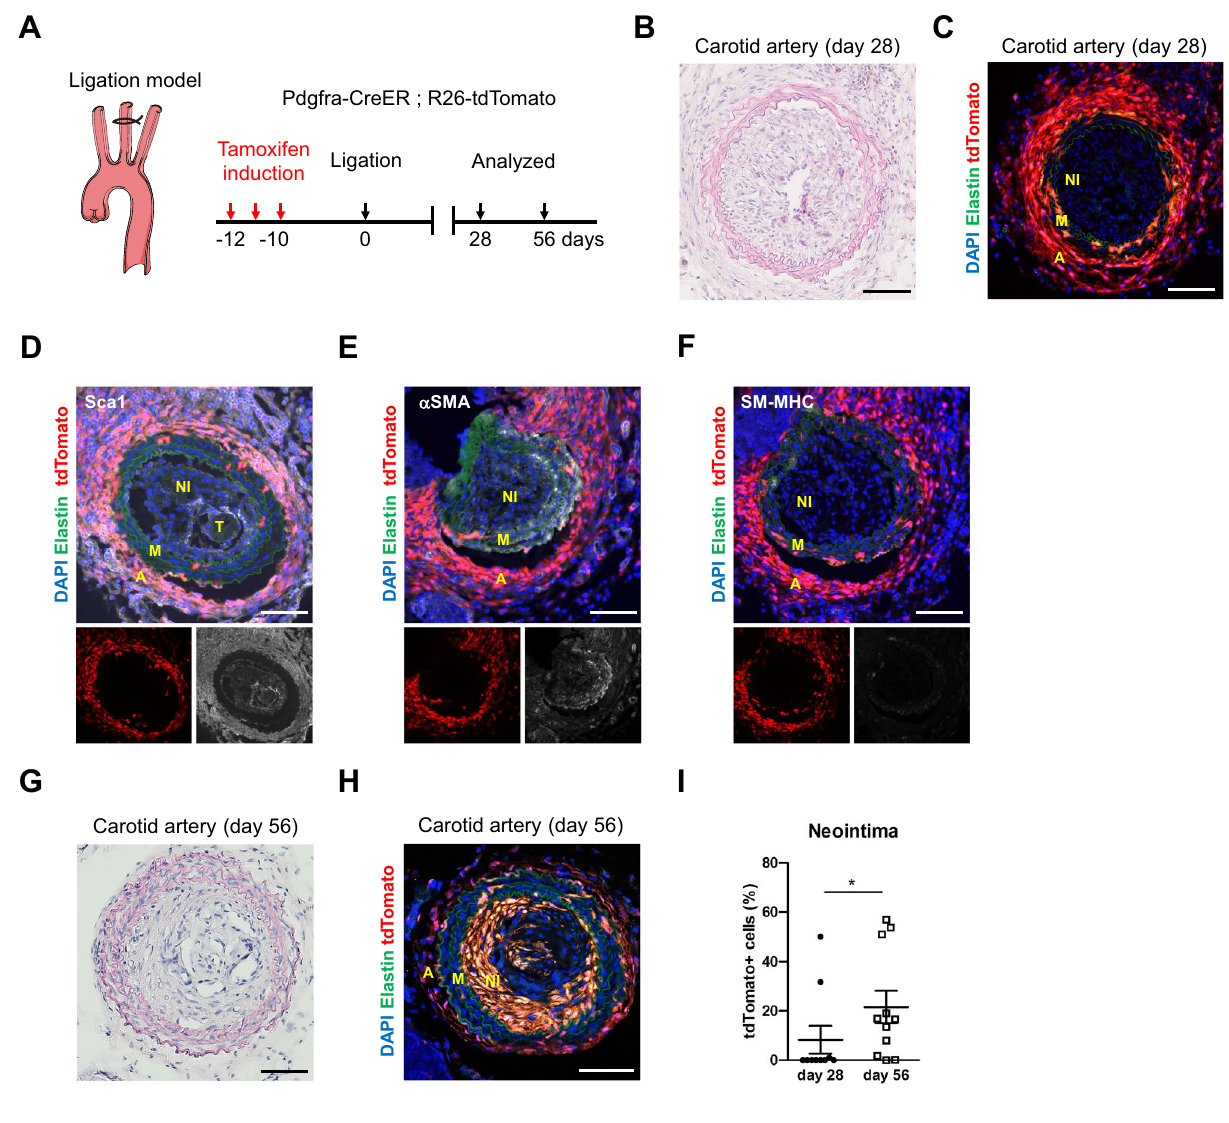
Figure 3. Contribution of PDGFRa+ cells to neointima formation following carotid artery ligation. ( A ) Schematic outlining the experimental strategy. ( B ) Hematoxylin eosin-stained carotid artery at 28 days after ligation. Scale bar: 100 µm. ( C ) Fluorescence image showing the distribution of tdTomato+ cells at 28 days after ligation. NI: neointima, M: media, A: adventitia. Scale bar: 100 µm. ( D – F ) Immunostaining for Sca1 ( D ), αSMA ( E ), and SM-MHC ( F ) on carotid artery sections at 28 days after ligation. NI: neointima, M: media, A: adventitia, T: thrombus. Scale bars: 100 µm. ( G ) Hematoxylin eosin-stained carotid artery at 56 days